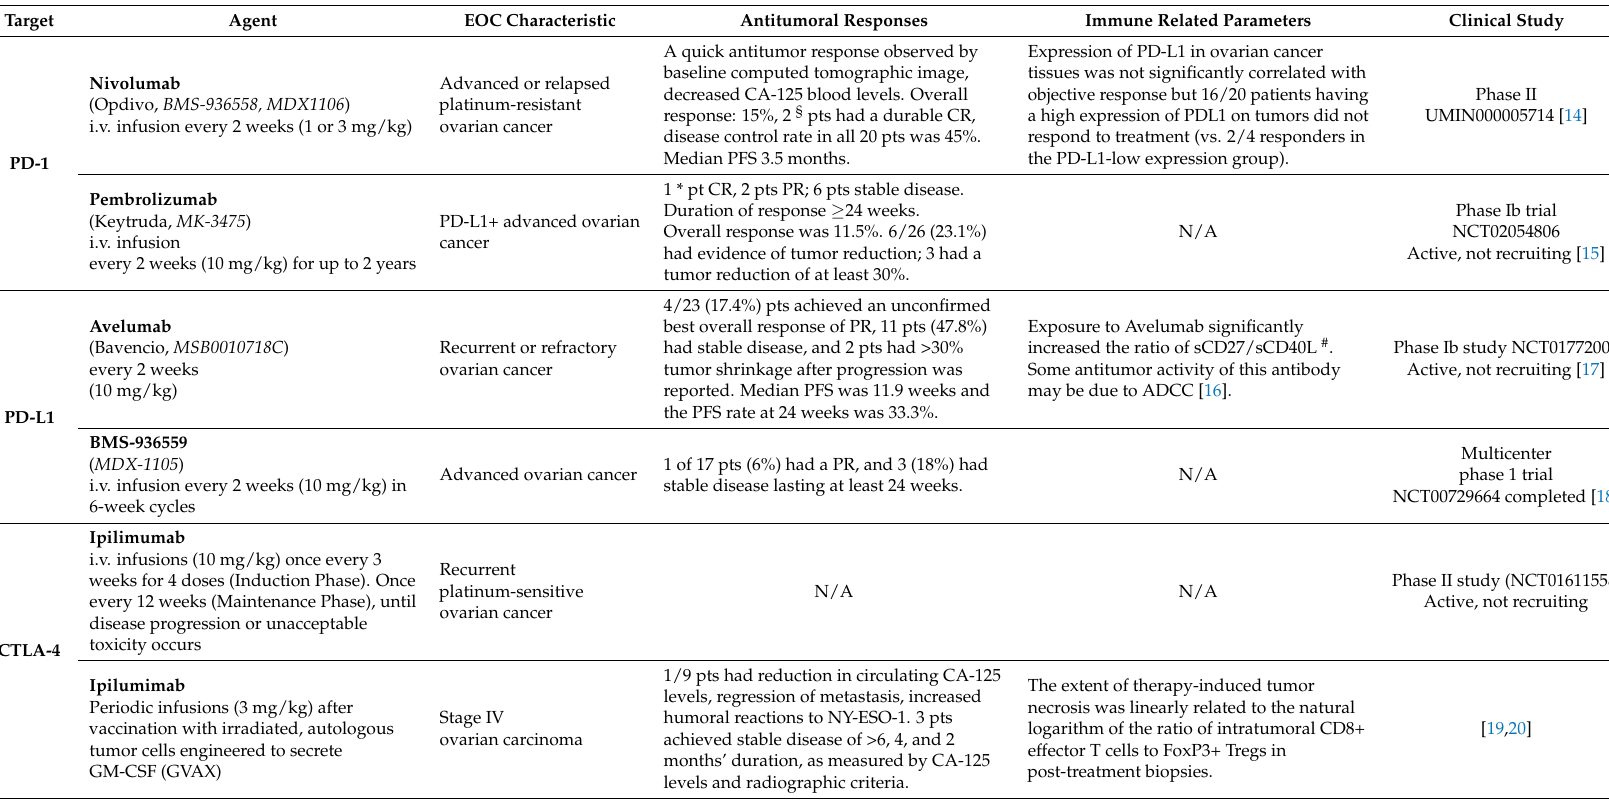
Table 1. Human studies using immune checkpoint inhibitors in epithelial ovarian cancers (EOC) (completed or partially completed